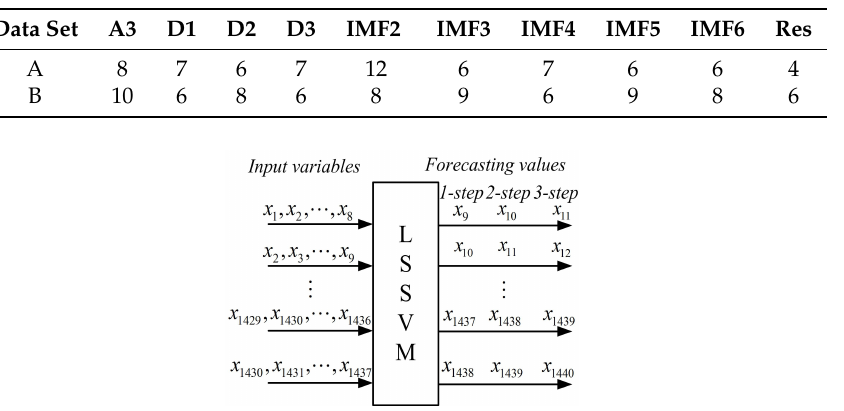
Figure 8. Construction of input matrix of the decomposed componoent A 3 of dataset A for the proposed